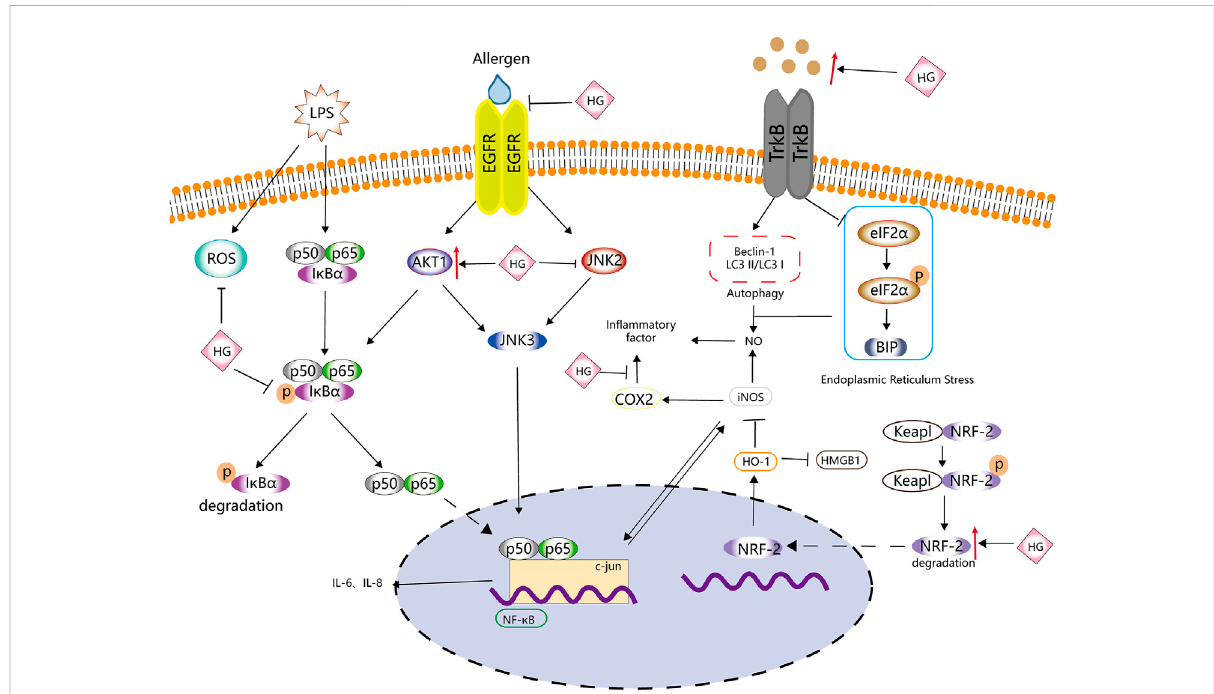
FIGURE 3 Anti-in fl ammatoryeffectsofHG.HG inhibits in fl ammationbyaffecting ROS,NF- κ B,iNOSandNRF-2-related in fl ammatorysignallingpathways and the related upstream and downstream targets.